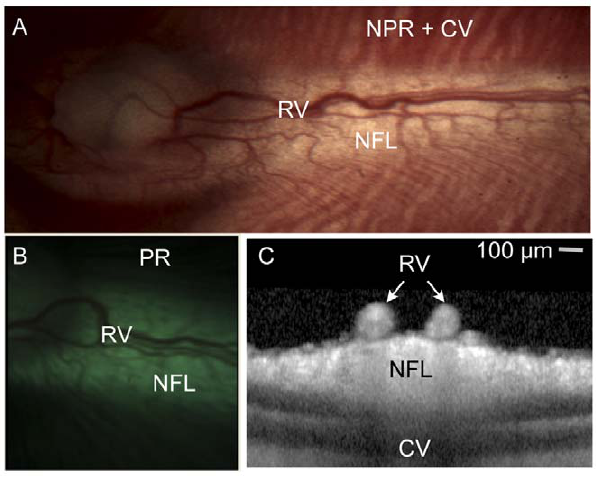
Figure 1. Illustration of rabbit retinal anatomy in one represen- tative albino (panel a) and pigmented (panel b) animal. (A,B) Color photographs of the retina at low magnification illustrate the relationship between the retinal vessels (RV), non-pigmented nerve fiber layer (NFL), non-pigmented retina (NPR) with visible choroidal vessels (CV) and pigmented retina that obscures underlying choroidal vessels (PR). (C) Optical coherence tomography of the retina in cross- section demonstrates that the retinal vessels lay on top of the unpigmented, myelinated nerve fiber layer. Note the complete lack of pigmentation in the albino animal versus the pigmented animal. Scale bar 100 microns (for panel C only).